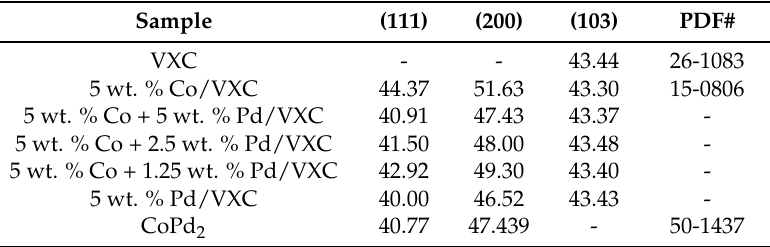
Table 2. Diffraction position for (111), (200), and (103) phases.